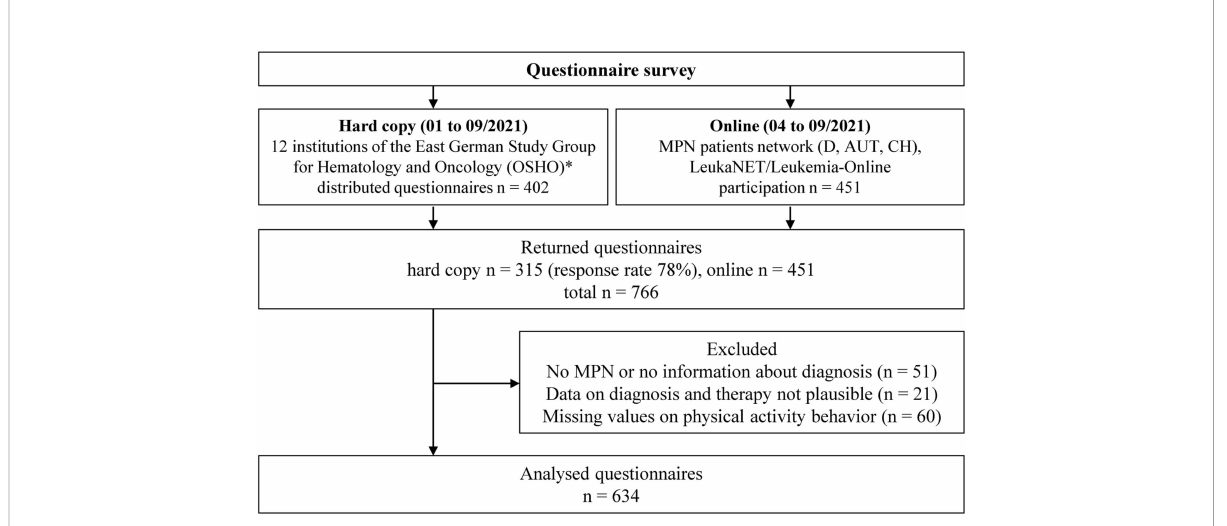
FIGURE 1 Flow chart of the study. D , Germany; AUT , Austria; CH , Switzerland; MPN , myeloproliferative neoplasms. *Participating institutions are presented in the supplement (Table